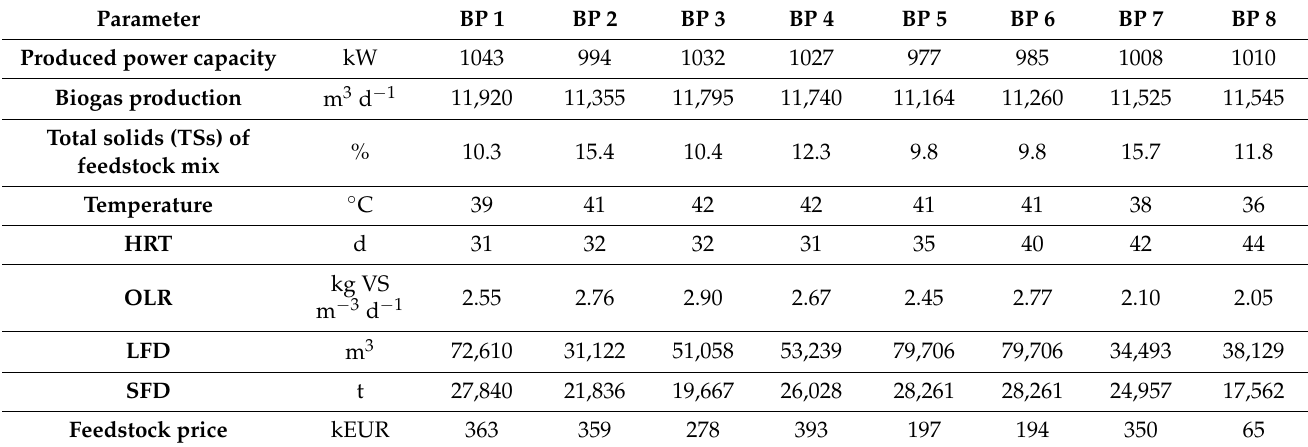
Table 3. Key parameters of biogas plants from which solid and liquid digestate streams were periodically analyzed. The produced power is the average power per 8200 annual operational hours. The feedstock mix is calculated in terms of each feedstock amount used during the experimental year at each biogas plant. Parameter Biogas